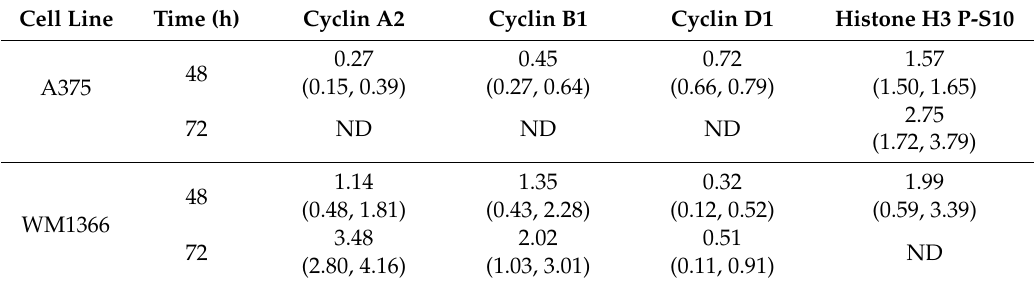
Table 5. Protein expression levels following siCDK11 transfection—Cell cycle pathways. Cell